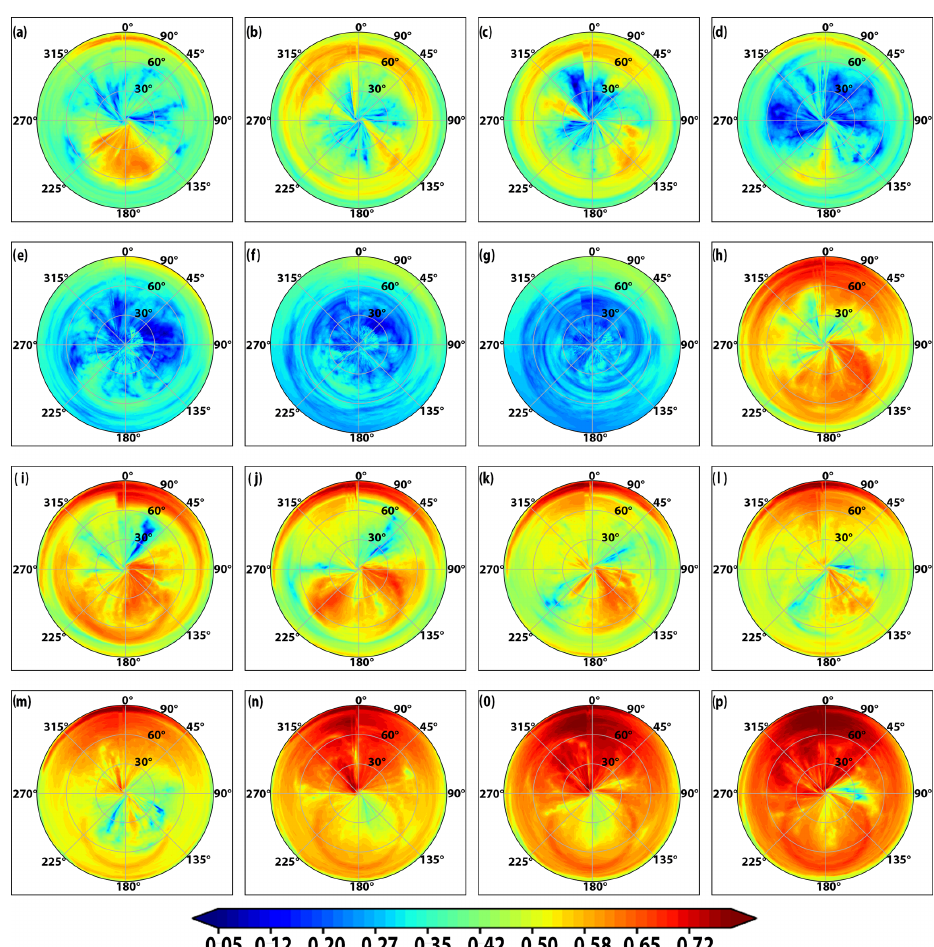
Figure 5. BRF at λ = 0.472µm for different solar zenith angles (23 ◦ < SZA < 34 ◦ ) and cloud optical thickness. Marine stratocumulus clouds are often extensive and flat but contain areas that have thinner clouds or even open cells that allow radiation to penetrate through, and therefore they have lower BRF values, as shown in blue. A prominent feature of marine stratocumulus clouds is the presence of a cloud bow ring associated with scattering by water droplets and with a peak at an approximately 75 ◦ zenith angle in the antisolar